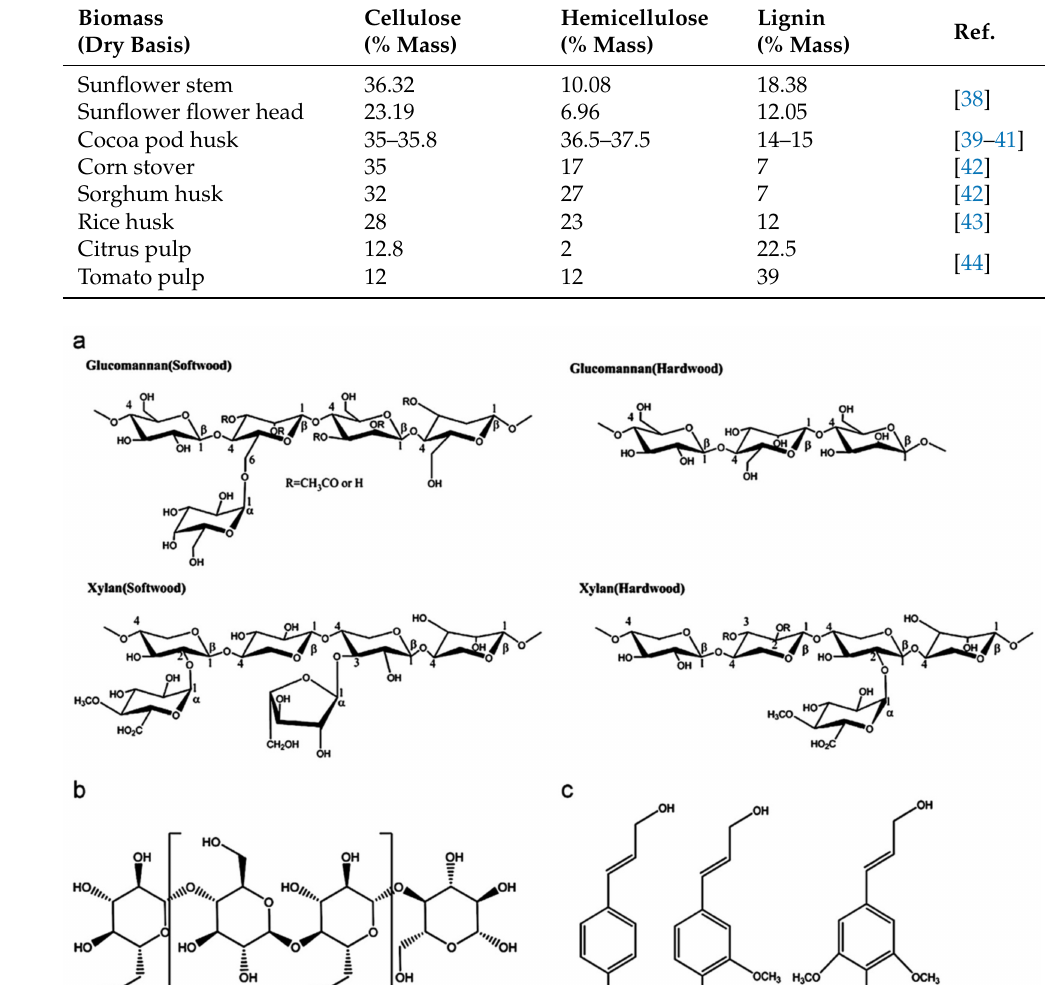
Table 1. Cell wall composition of different types of lignocellulosic waste.